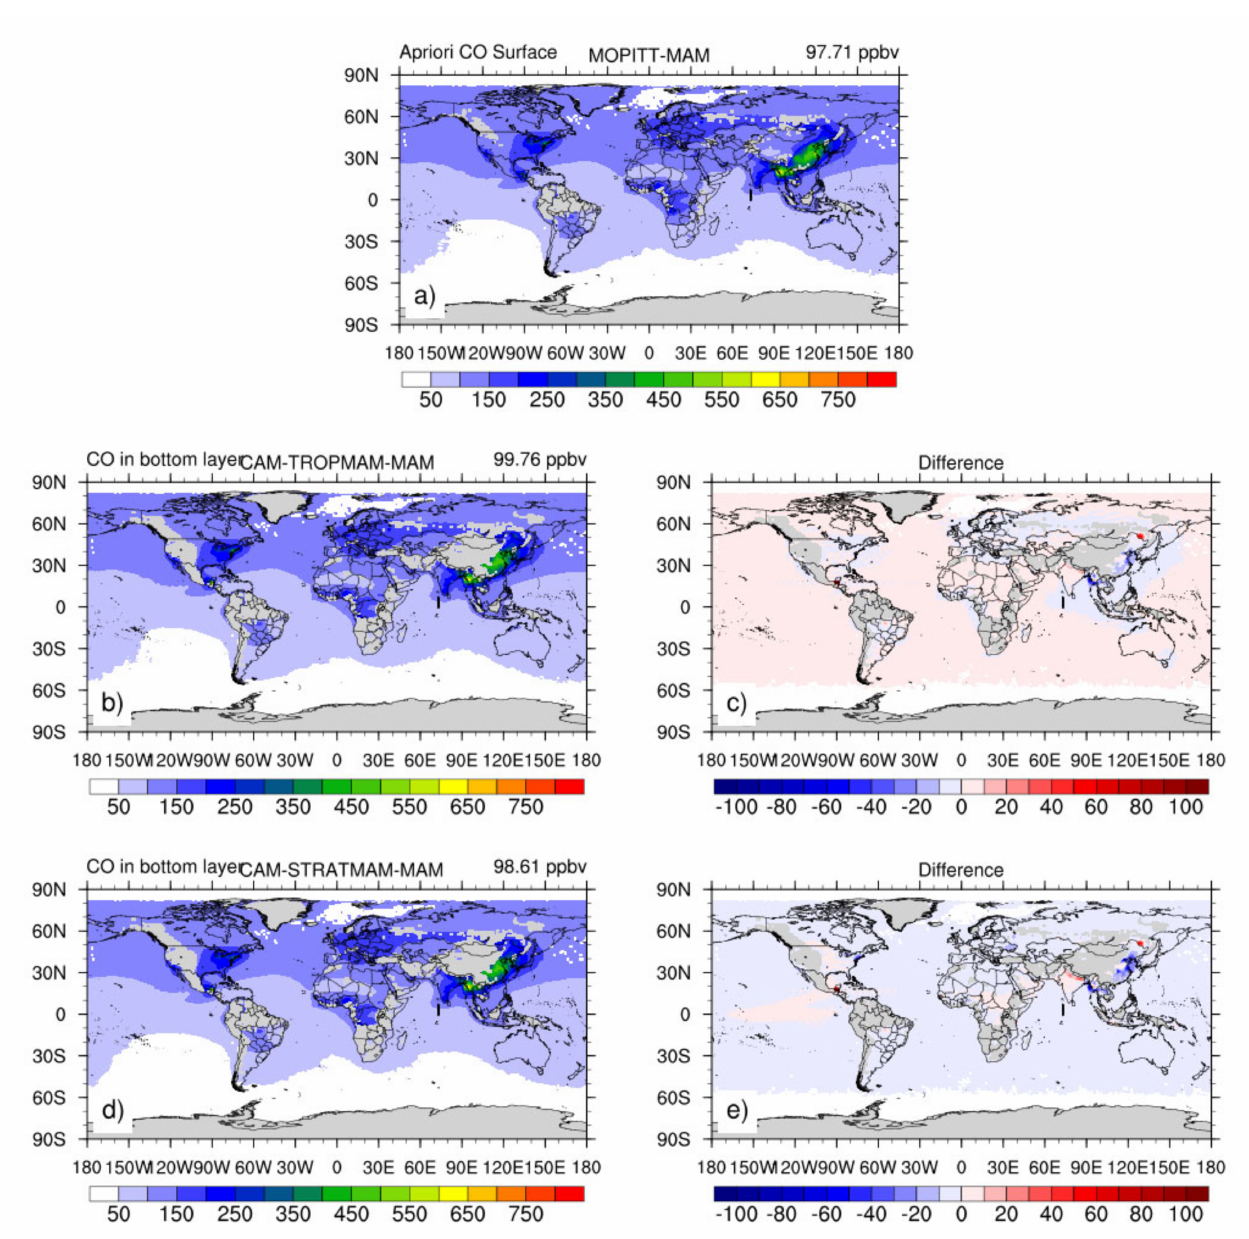
Figure 2. ( a ) CO (ppb) observed by MOPITT sensor for March-April-May (MAM), in the period of 2010–2014, ( b ) CO simulated by the CAM5-MAM3 model using tropospheric chemistry and ( d ) tropospheric/stratospheric chemistry mecha- nisms using the calculations of Equation (4). The right side of the figure shows the model difference minus the observation (MOPITT), ( c ) for tropospheric chemistry and ( e ) for tropospheric/stratospheric